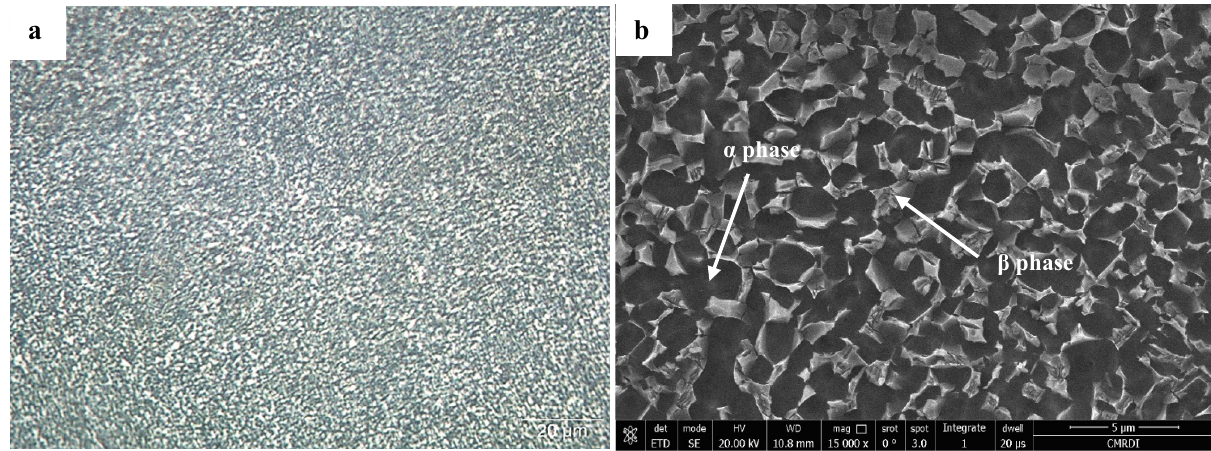
Figure 1. As received α/β equiaxed microstructure of TC21 Ti-alloy ( a ) Optical micrograph ( b )